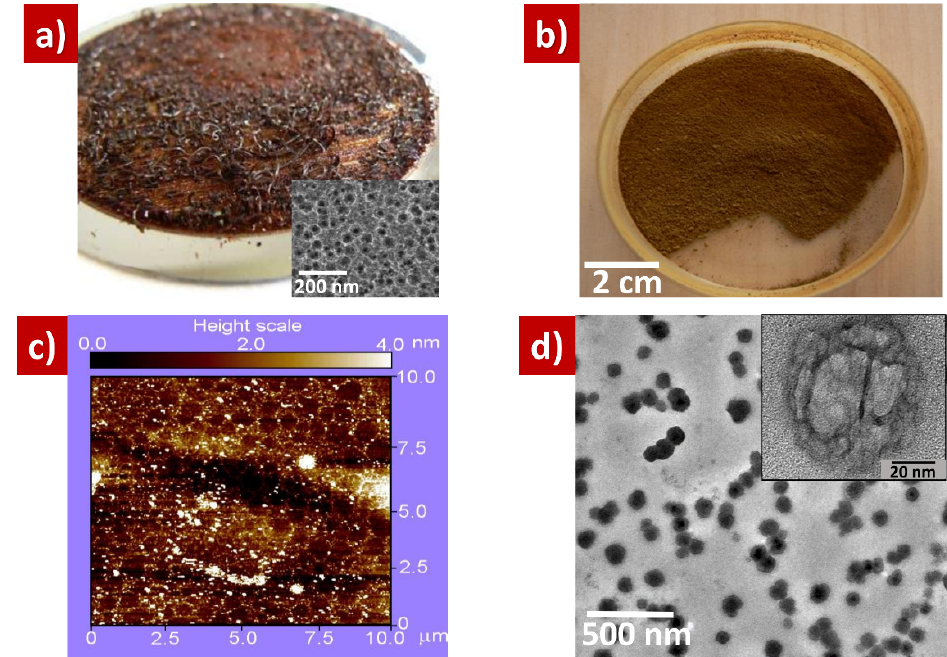
Figure 3. ( a ) As-prepared hydrogenated highly porous silicon film, inset: SEM top view image of the nanoporous Si film; ( b ) PSi nanopowder obtained by mechanical grinding of the PSi layer; ( c ) AFM image of the PSi nanoparticles constituting the PSi nanopowder; ( d ) TEM images of the PSi nanoparticles, inset: single PSi